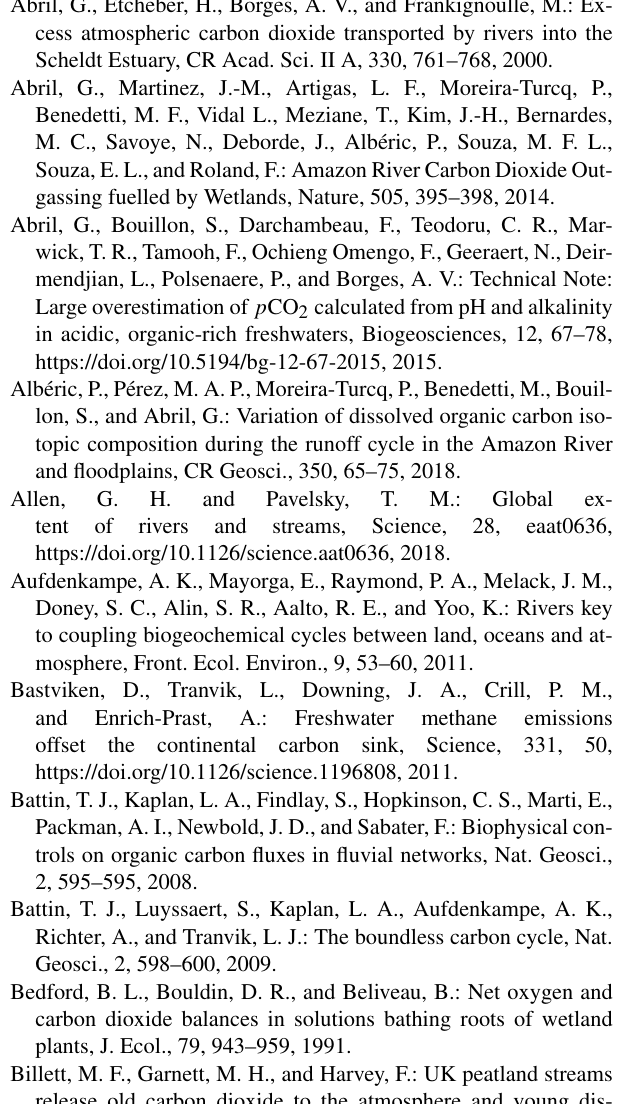
Table 1; GA and AVB equally contributed to literature reading and the writing of the